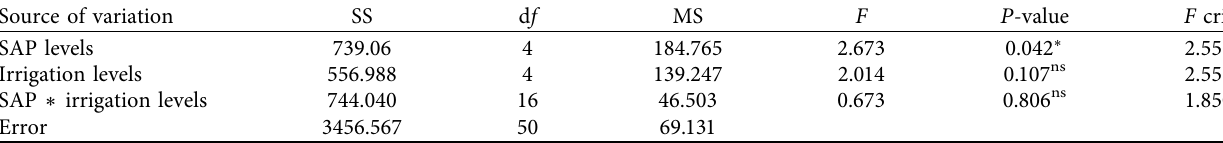
Table 7: ANOVA for dependent variables and their interaction on African nightshade plant yield at 95% confidence level. Source of variation Irrigation